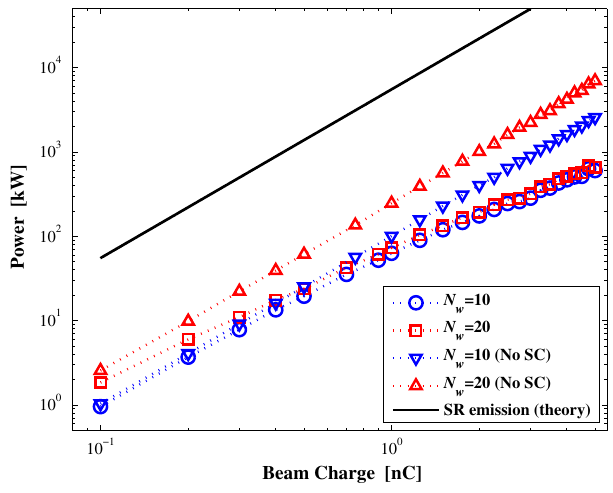
FIG. 9. Prebunched FEL radiation power as function of the beam pulse charge. The modulation index and the modulation frequency are m ¼ 50% and f m ¼ 3 THz,